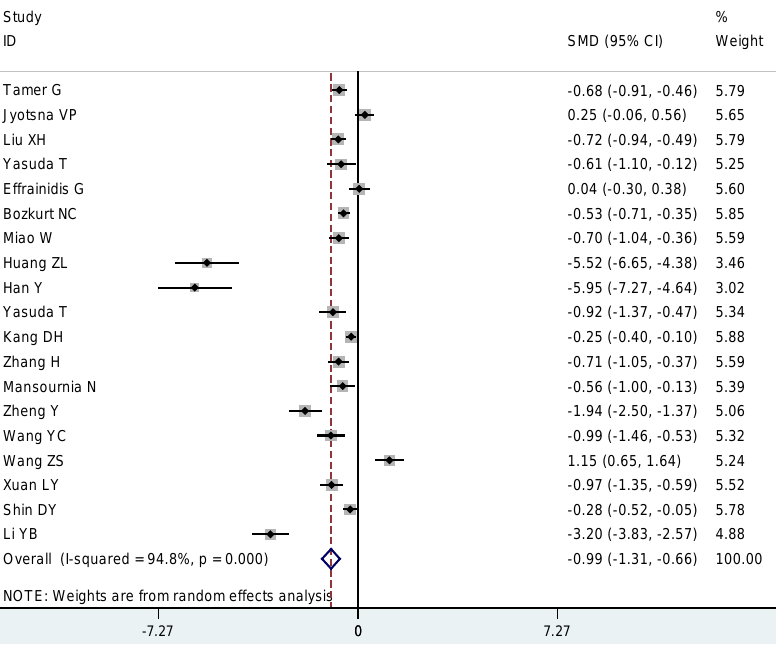
Figure 2. Meta-analysis of studies (chronologically ordered) reporting 25(OH)D levels in autoimmune thyroid disease (AITD) vs. controls, standardized mean difference with 95% confidence